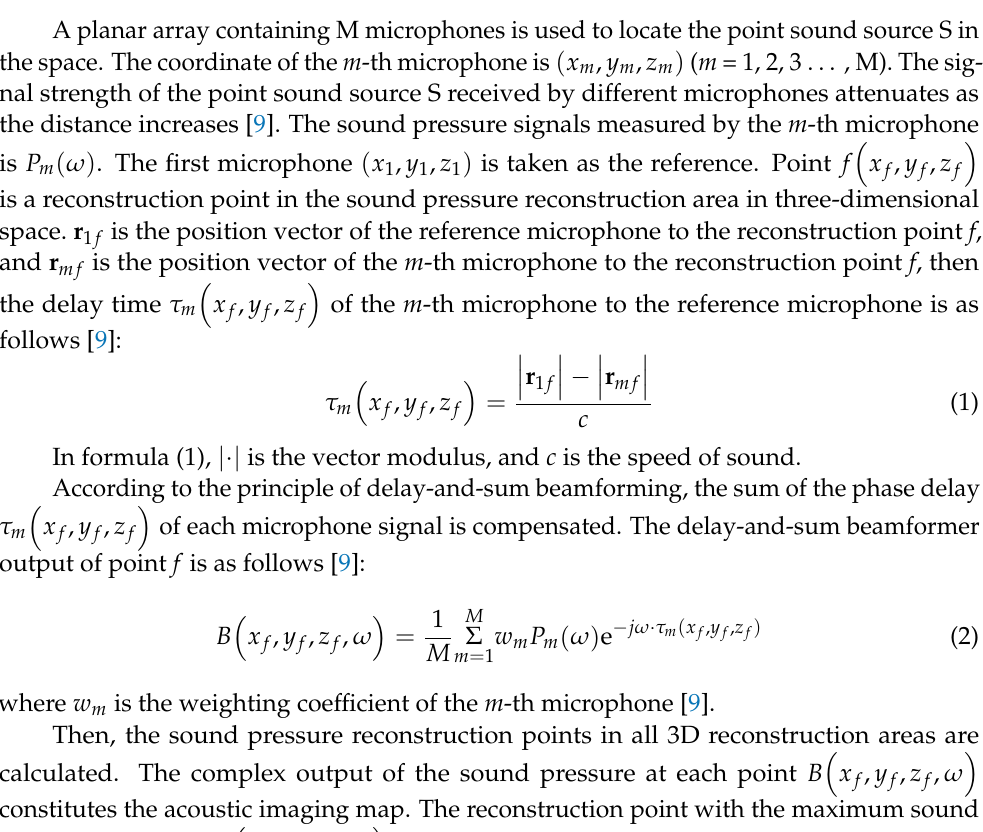
Figure 1. Principle of space